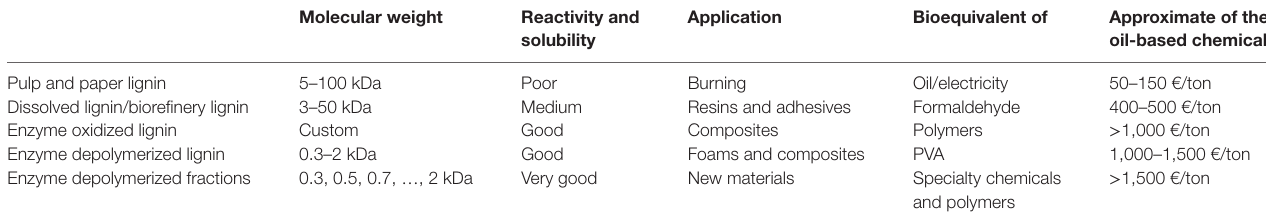
TaBle 1 | Valorization of lignin by oxidative upgrade and fractionation.